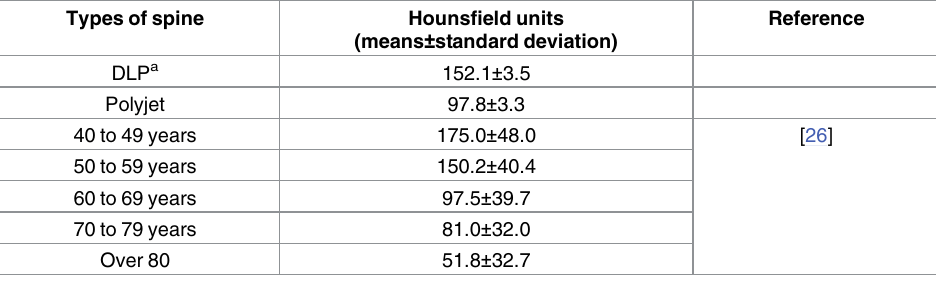
Table 2. The mean and standard deviation of the HU values from the spine body for the different 3D printing techniques and for the different patient